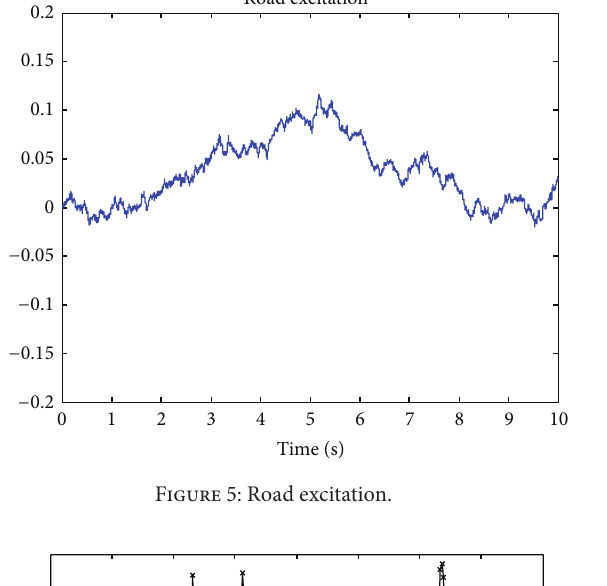
Figure 5: Road excitation.